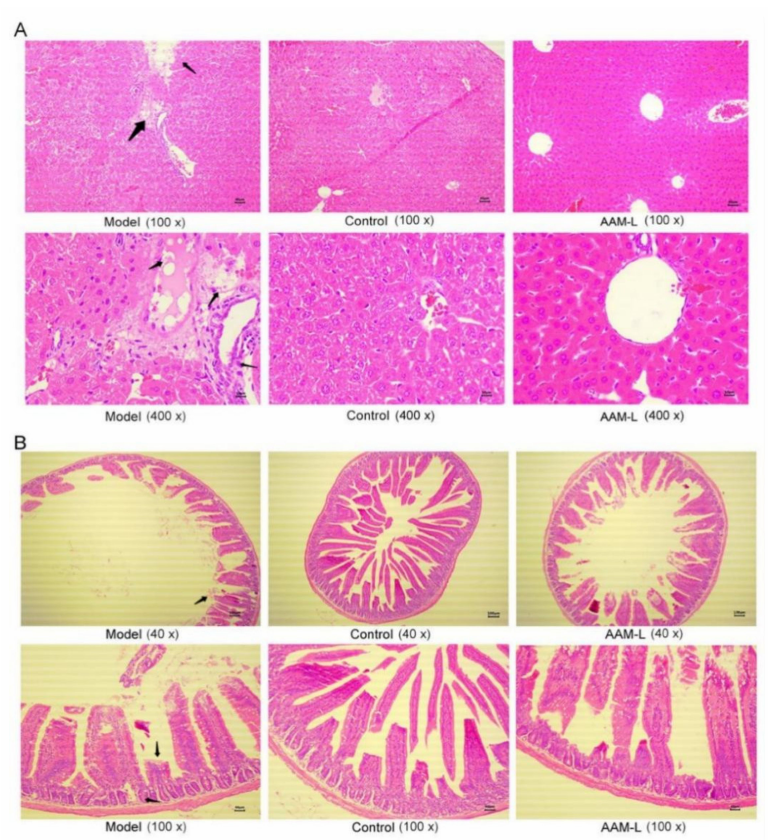
Figure 4. Effects of AAM administration on histopathological features of liver and small intestine in mice exposed to alcohol intake for consecutive 6 weeks. ( A ) Histopathological features of liver; ( B ) Histopathological features of small